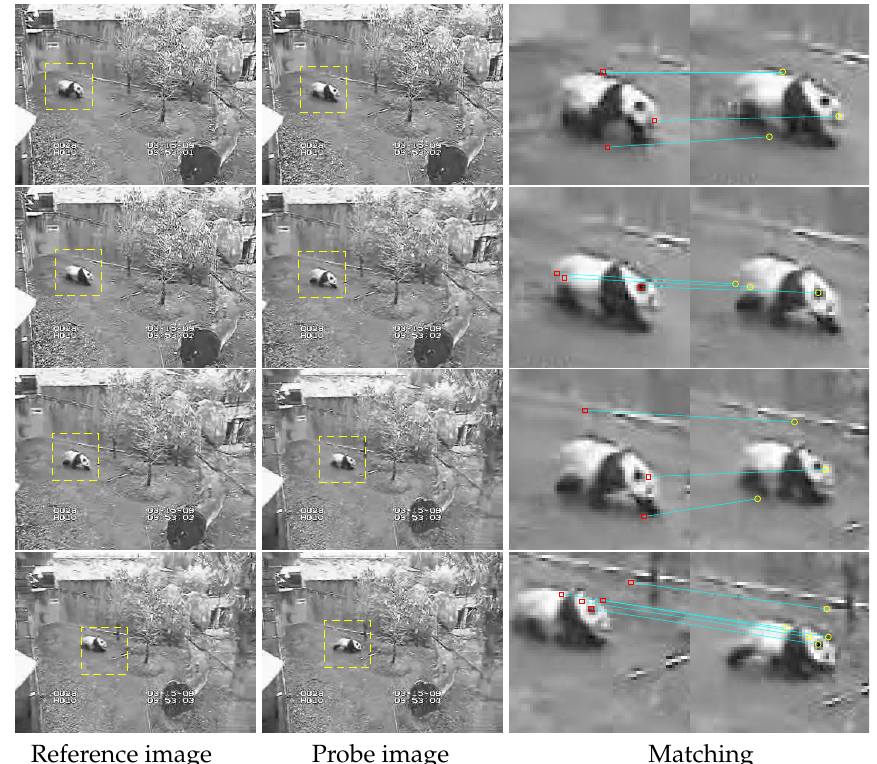
Figure 6. Second feature matching test. In the first two columns, moving objects are marked, and, in the last column, there are marked key-points (as red squares and yellow circles) with an indication of their position on two different frames with a blue line.